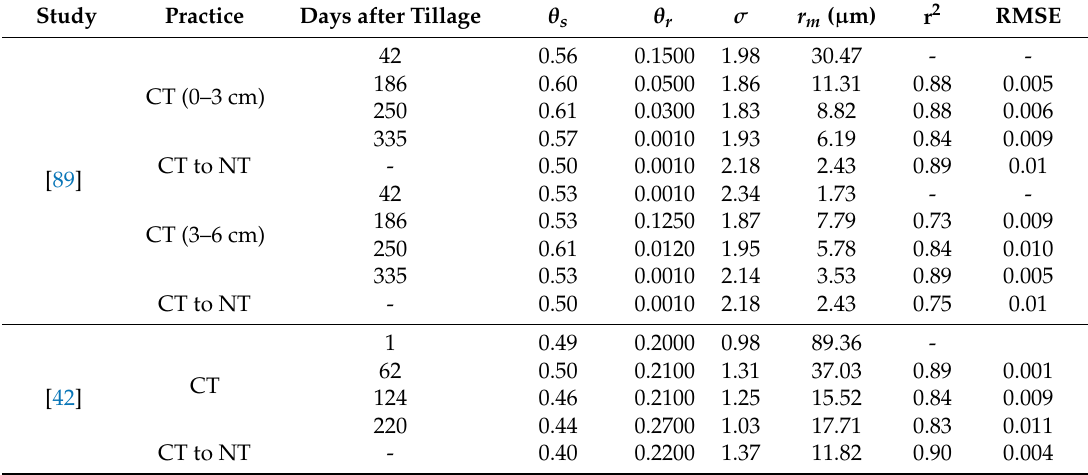
Table 2. Water retention parameter and model